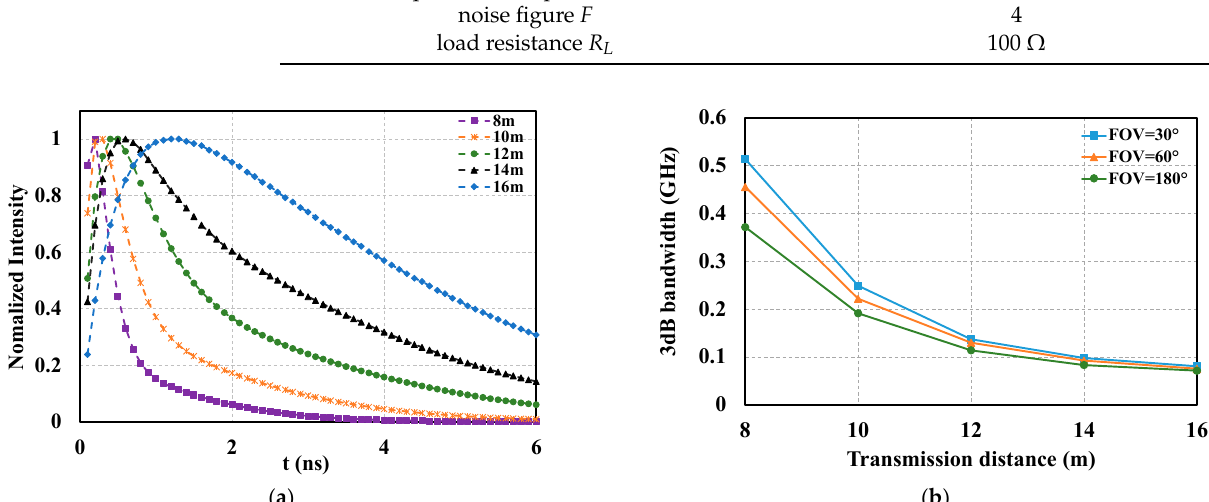
Figure 9. ( a ) The normalized channel impulse response with different link range. ( b ) 3 dB channel bandwidth versus transmission distance under FOV of 30°, 60°, and 180°.